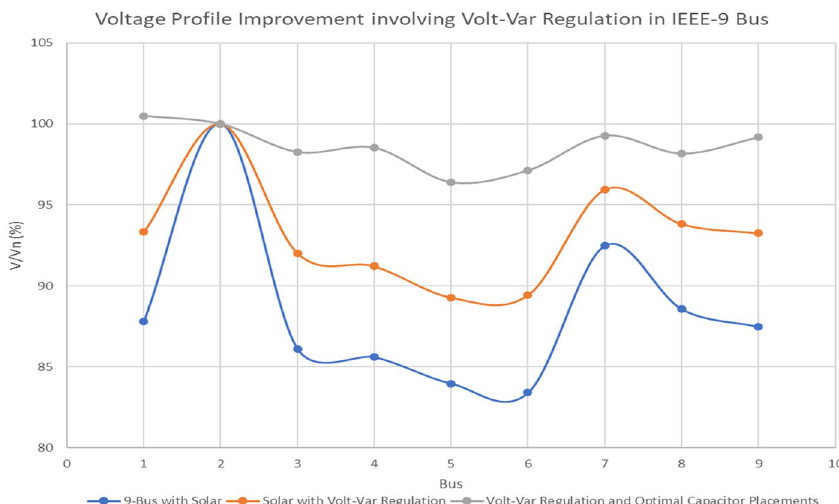
Fig. 12 Voltage profile improvement using volt-var methods and volt-var regulation with optimal capacitor placement in IEEE-9